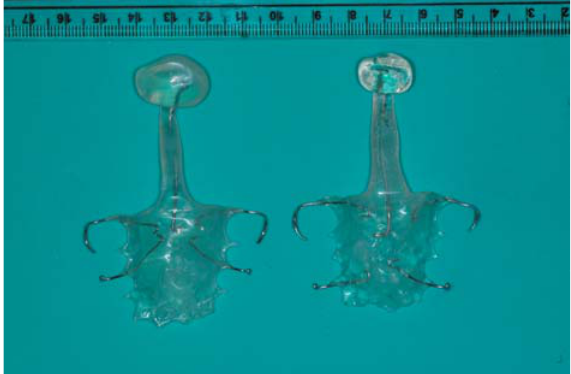
Figure 6- Speech bulb original X Speech bulb with